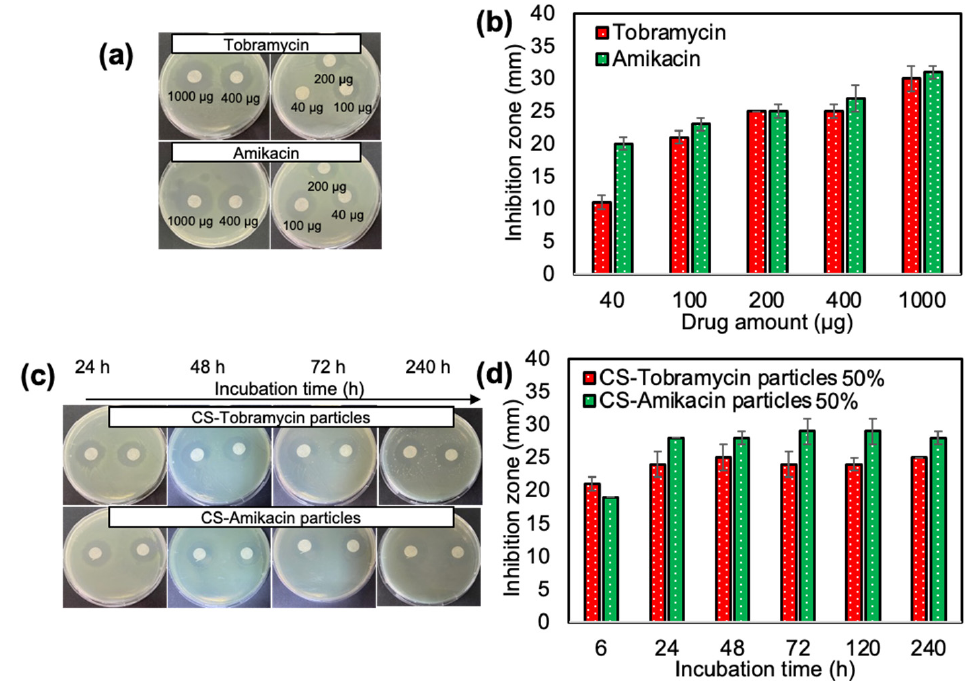
Figure 4. ( a , b ) Inhibition zone (mm) for tobramycin and amikacin drugs at different concentrations; 20 μ L of 2–50 mg/mL for 24 h incubation, and ( c , d ) drug-loaded CS-Tobramycin 50% and CS-Amikacin particles 50% at 50 μ L of 50 mg/mL concentration against P. aeruginosa at different incubation times.